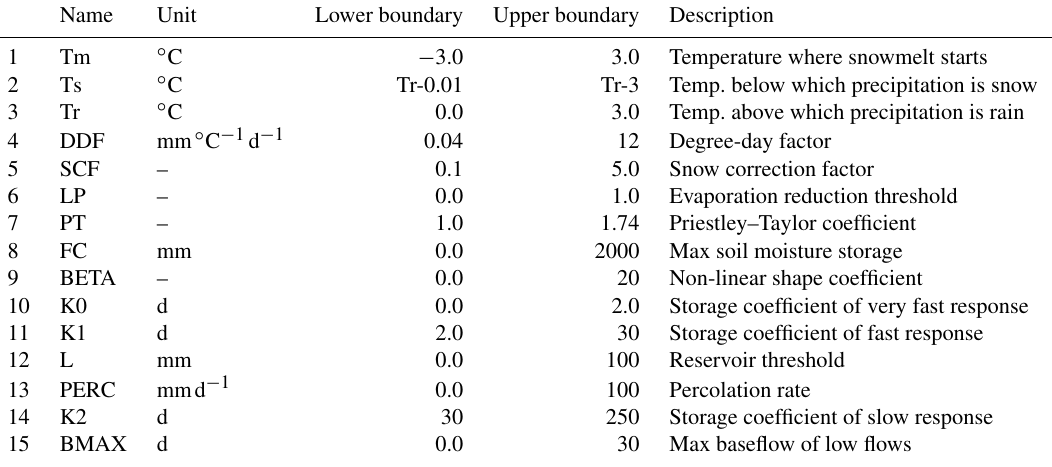
Table A1. Selected parameters, their classification, and their boundaries for the HBV model. The parameters and their boundaries are based on Parajka et al. (2007), Uhlenbrook et al. (1999), and Abebe et al. (2010). The Priestley–Taylor parameter is based on Lhomme (1997).